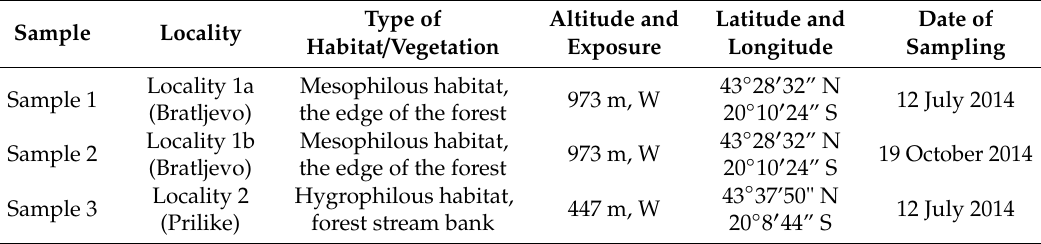
Table 5. General sampling data of I. helenium